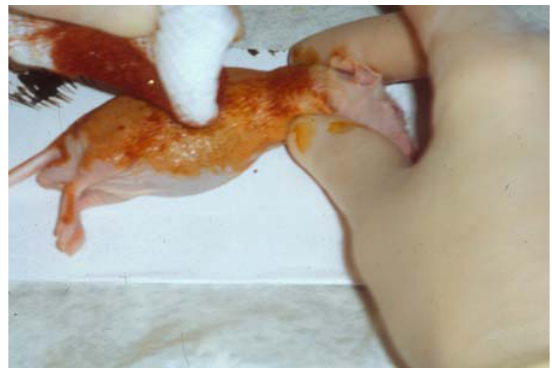
FIGURE 1 – Dorsum of the mice washed with